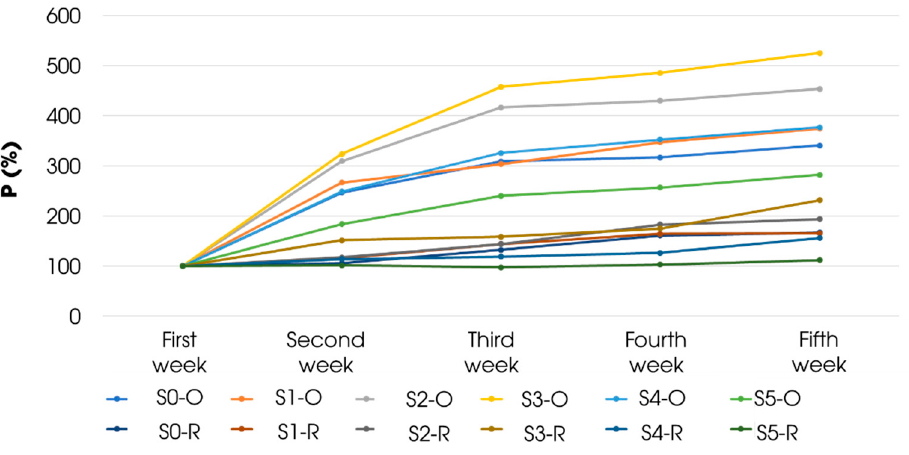
Figure 15. The rate of polymerization of the different dried extracts at room temperature and at 45 °C.